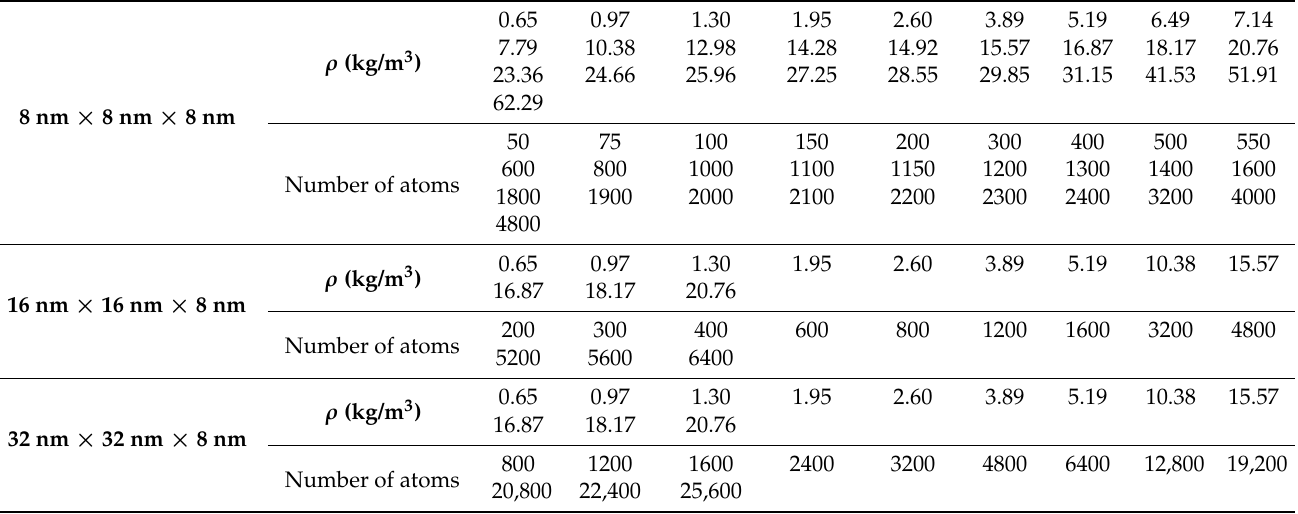
Table 1. The number of helium atoms corresponding to different helium densities ρ in the simulation box with different